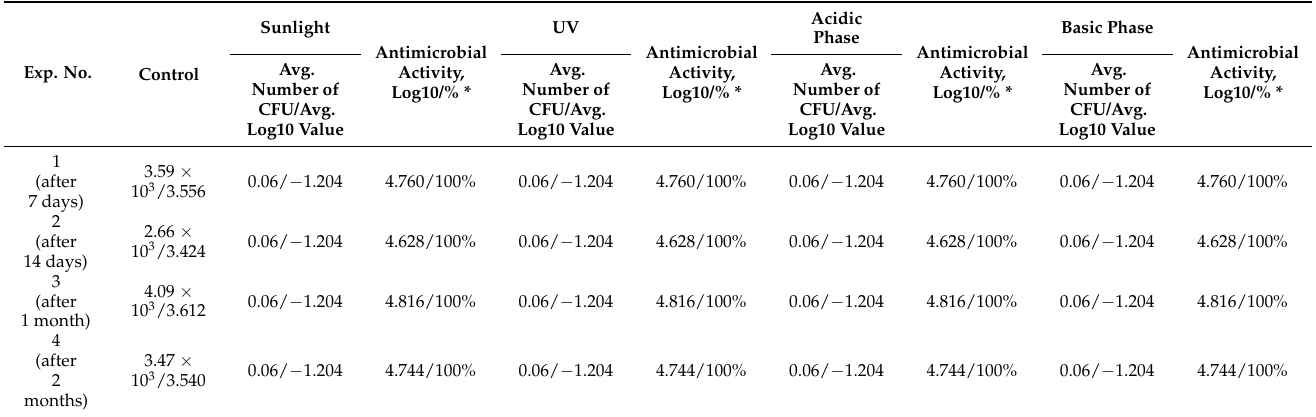
Table 8. The results of the antimicrobial activity of the polymer composite with triclosan subjected to aging